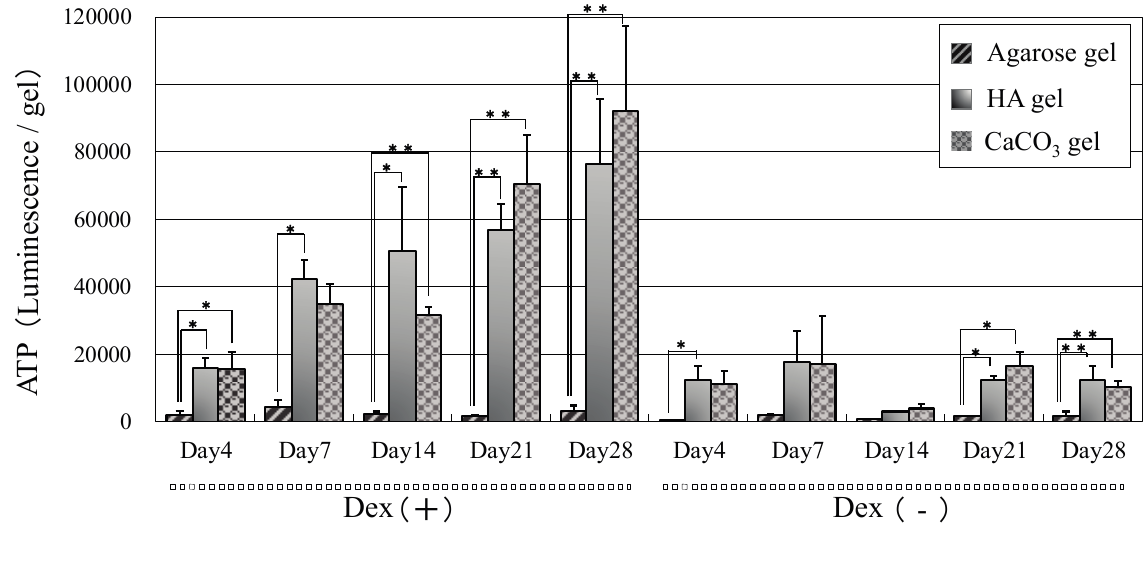
Figure 3. Adenosine triphosphate (ATP) content of MSCs cultured in the presence (Dex (+)) or absence (Dex ( − )) of dexamethasone (Dex) on agarose, HA/agarose, and CaCO 3 /agarose gels. The data represent means ± SD ( n = 6). * p < 0.05, ** p < 0.01.